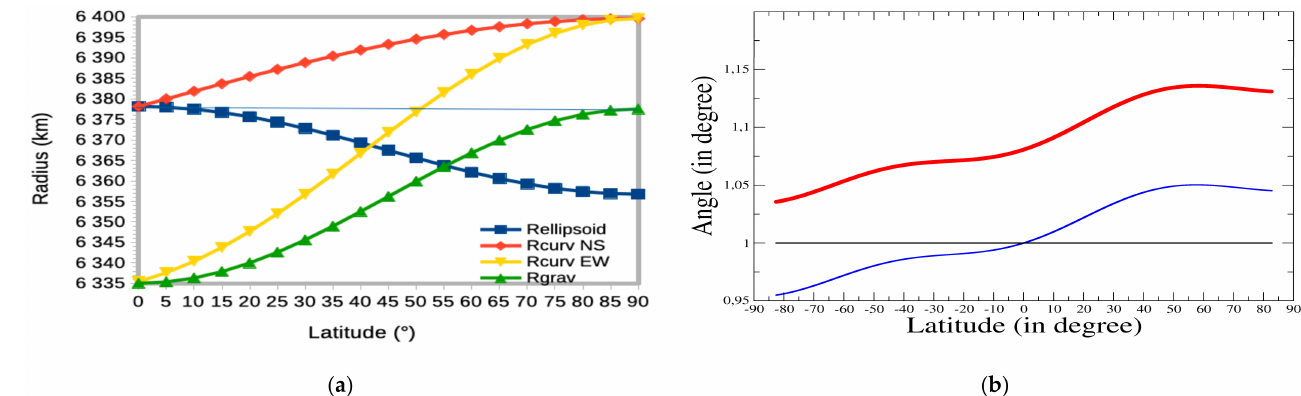
Figure 10. ( a ) Latitude dependences of R ellipsoid the ellipsoid radius (distance to the Earth centre), of R curv the tangent sphere radius (for two azimuths) and of R grav the radius used for gravity computation. ( b ) For one orbit: in black tau the fixed tilt of the platform in geodetic frame, in blue θ sat = µ (H sat ) the angle between the beam direction and the vertical at the satellite level and in red µ (0 ) the satellite viewing angle from the